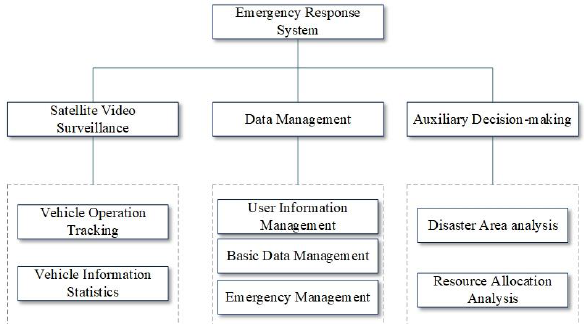
Figure 2. Functional structure of the